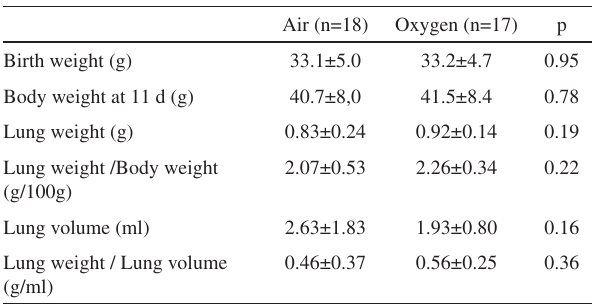
Table 1 - Lung weight and volumes